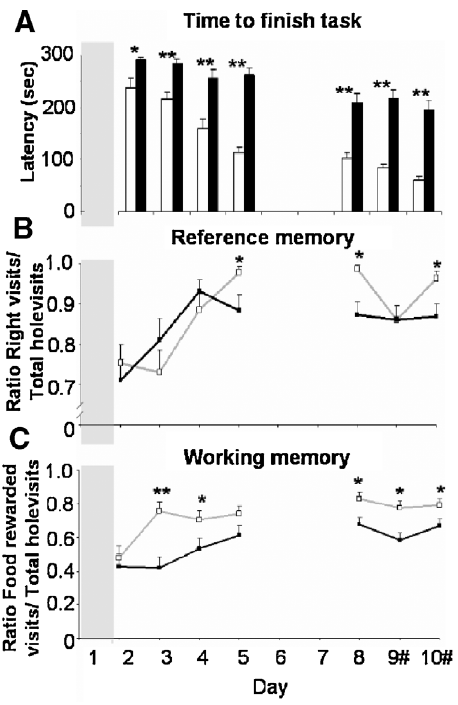
Figure 6. Cognitive parameters of modified holeboard performance of BALB/c (white bars, open squares, and gray lines) and C57BL/6J mice (black bars, filled squares, and black lines). ( A ) time to finish the task, ( B ) reference memory ratio, i.e., the number of baited cylinder visits divided by total cylinder visits, and ( C ) working memory ratio, i.e., the number of food rewarded cylinder visits divided by the number of baited cylinders visited. #: Baited cylinders were relocated on days 9 and 10. * p < 0.05 and ** p (cid:4) 0.001 between strains.